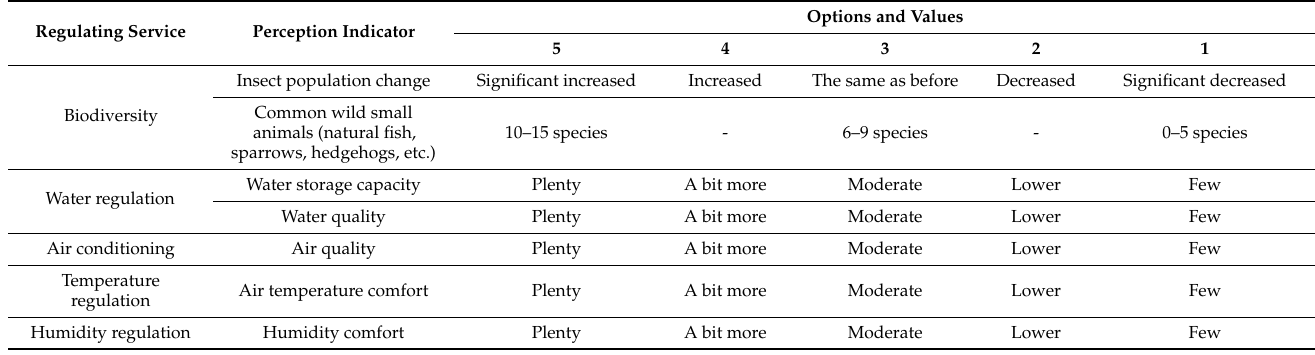
Table A3. Regulating service perception indicators, options, and